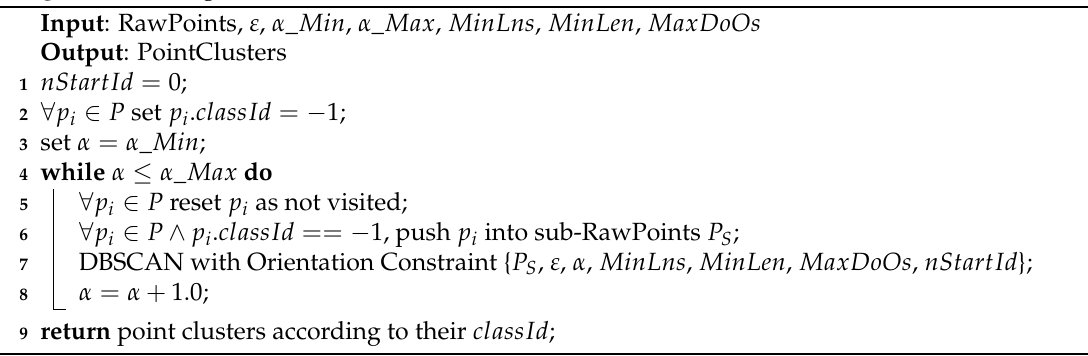
Figure 1. An illustration of the sensitivity of α . ( a ) Point set of raw GPS traces; ( b ) one of the generated point clusters with α = 1 ◦ ; ( c ) one of the generated point clusters with α = 5 ◦ . Algorithm 2: Progressive DBSCAN with an orientation